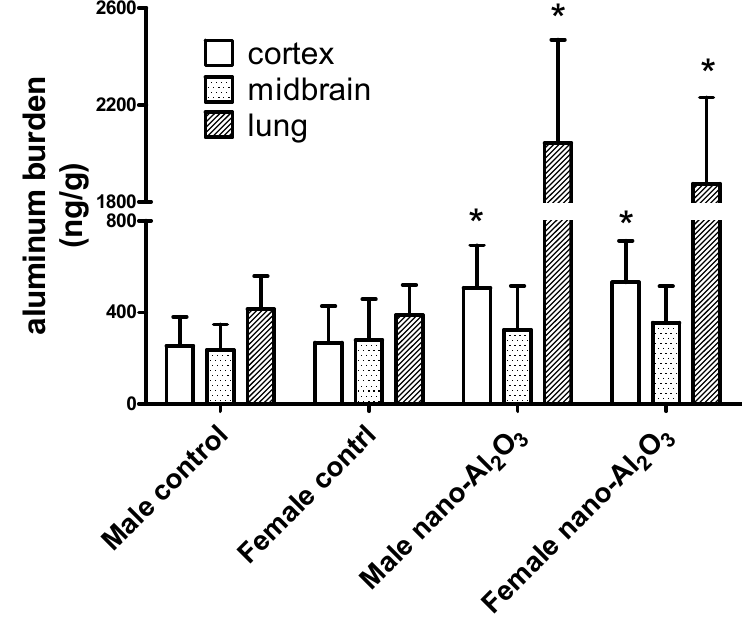
Figure 2. Aluminum burden in cortex, midbrain, and lung tissues of mice. * p < 0.05, compared with the corresponding sex control, n = 4.